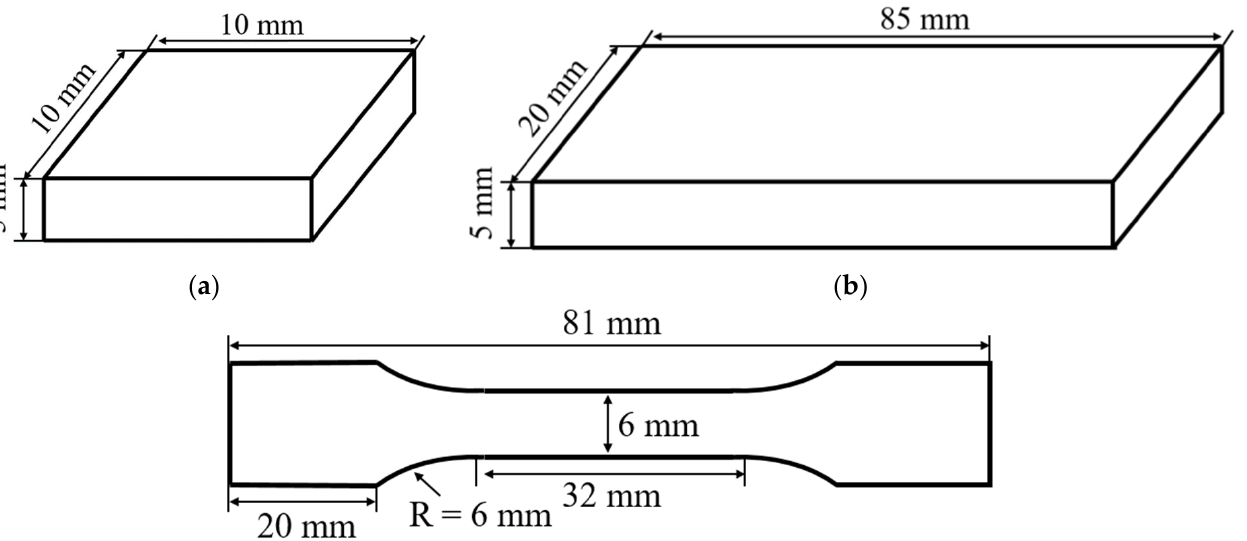
Figure 3. Design of specimens: ( a ) design of cuboid deposition specimen; ( b ) design of tensile specimen before cutting; and ( c ) design of tensile specimen after cutting.